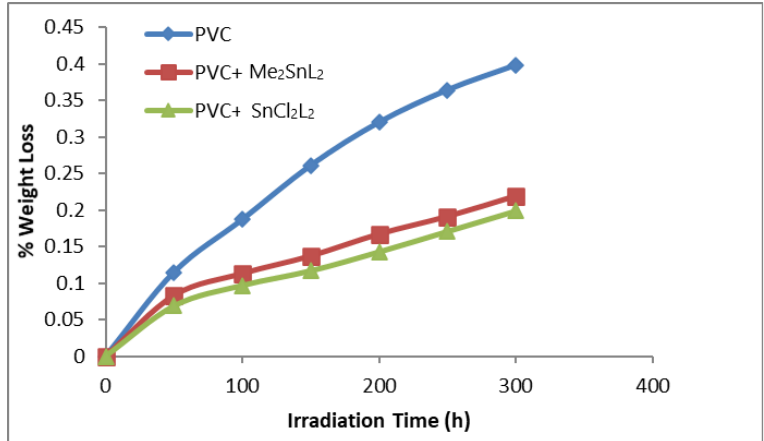
Figure 5. Changes in weight loss of PVC films with irradiation time.